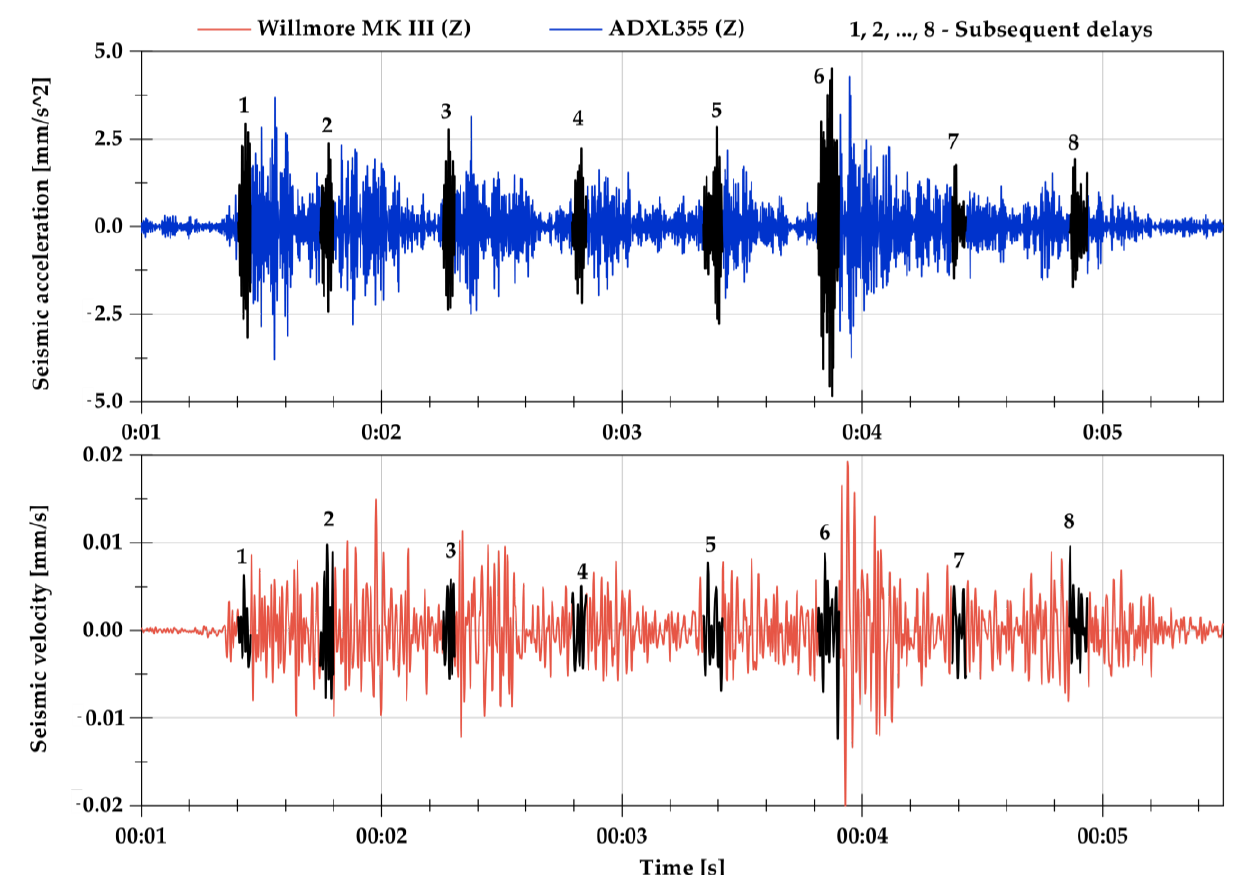
Figure 8. Determination of delay times of detonators with the use of recorded seismic waveforms.